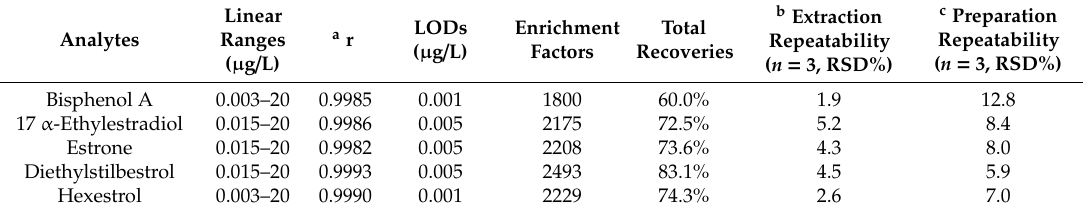
Table 1. Analytical performances of the in-tube solid-phase microextraction (IT-SPME)-HPLC method for